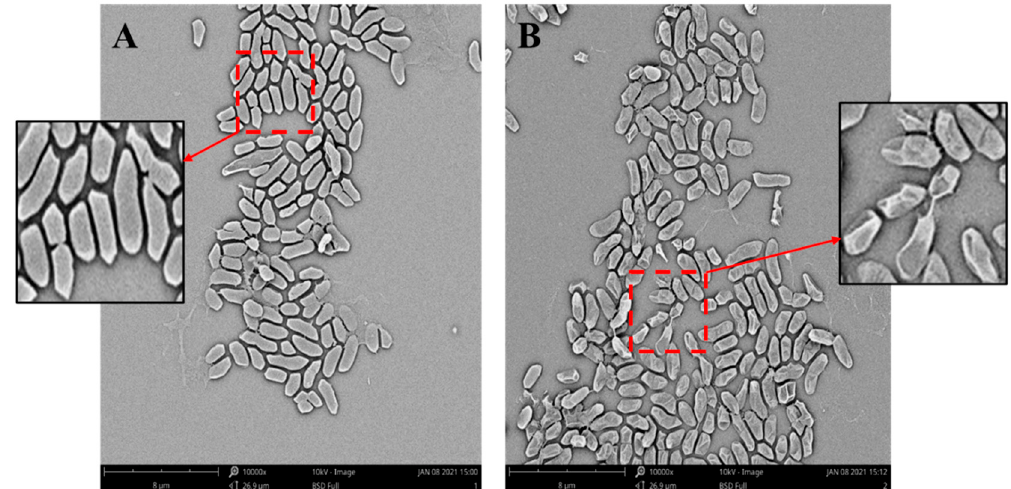
Figure 4. Scanning electron microscope (SEM) images of Pcb BZA12. ( A ), control with sterile saline; ( B ), treatment with bacteriocin of L. paracasei WX322 from tomato juice.